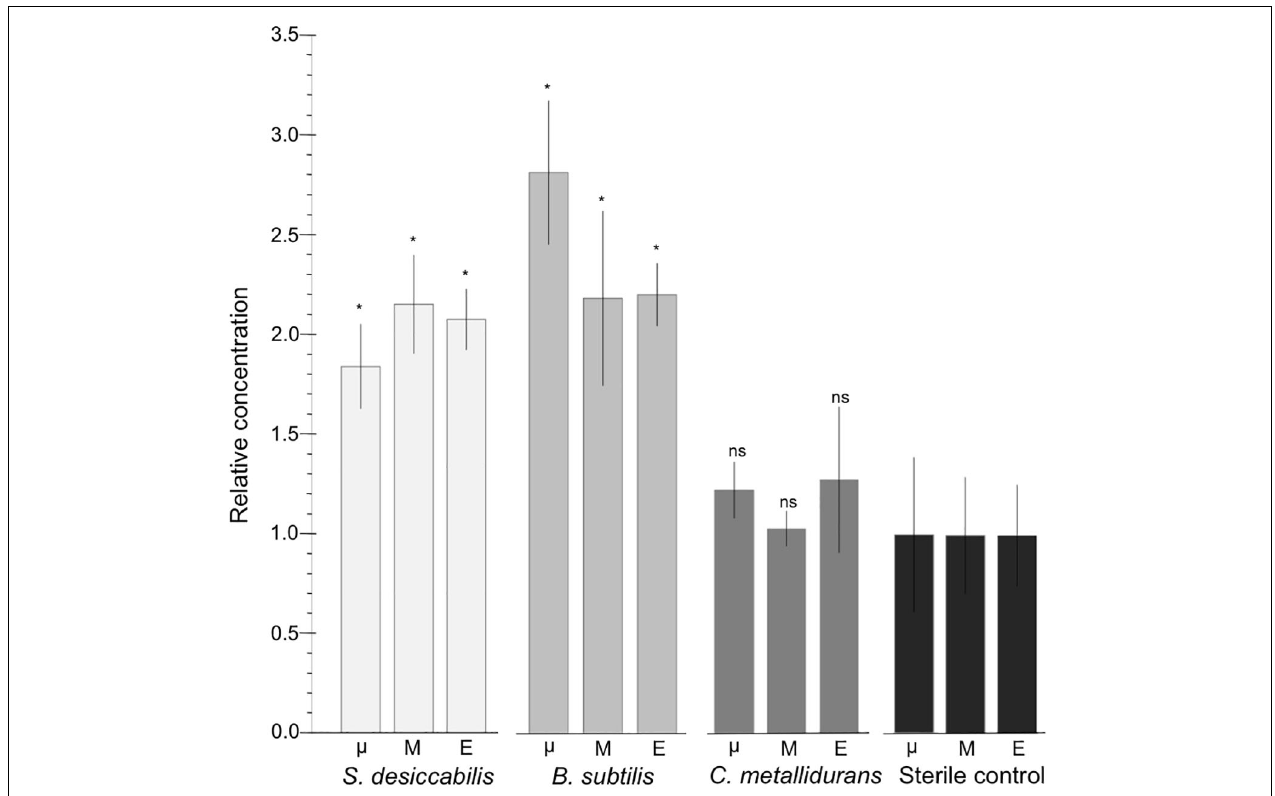
FIGURE 3 | Biological enhancement of vanadium leaching on ISS. Graph showing relative quantity of vanadium leached into the culture chamber for the different gravity conditions and organisms on ISS ( µ = microgravity; M = Mars gravity; E = Earth gravity). Data shown as a ratio of biology versus sterile controls. Asterisks reflect samples that are significantly different from the sterile controls ( p < 0.05). ‘ns’ means not significant. Sterile control data are also shown. n = 3, except for sterile controls in microgravity in which n = 2 due to contamination.